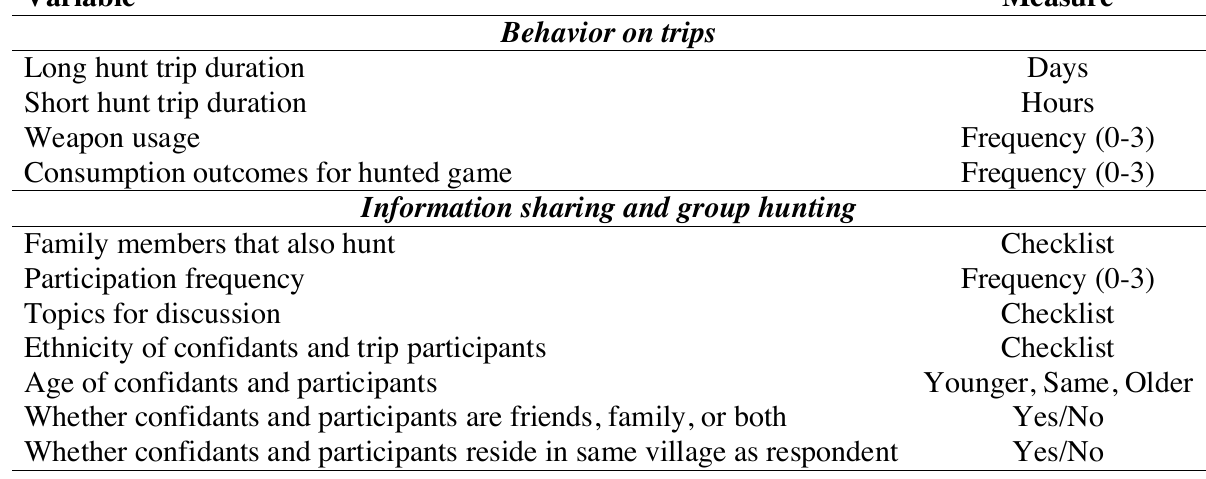
Table A3: Questions regarding hunter behavior on trips and interactions with other hunters. The “frequency” 0-3 score corresponds to never, rarely, sometimes, and always. For checklists, the respondent indicated whether each item was or was not relevant (e.g. “Ethnicity of confidants and participants” checklist would have check boxes for each of the ethnic